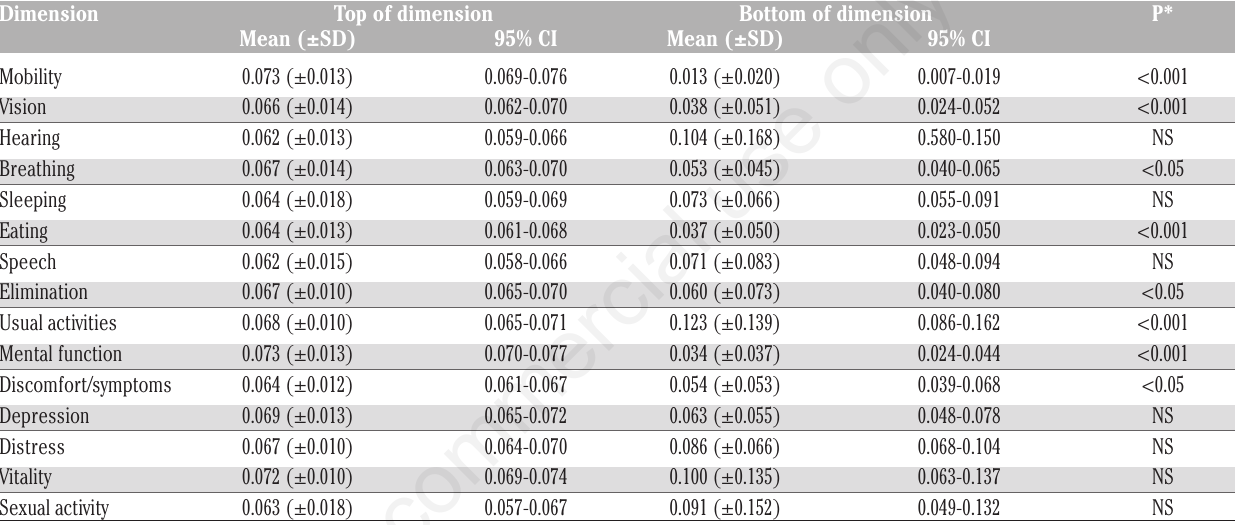
Table 2. Average importance weights for the bottom and top of the 15D dimensions (n=59). Dimension